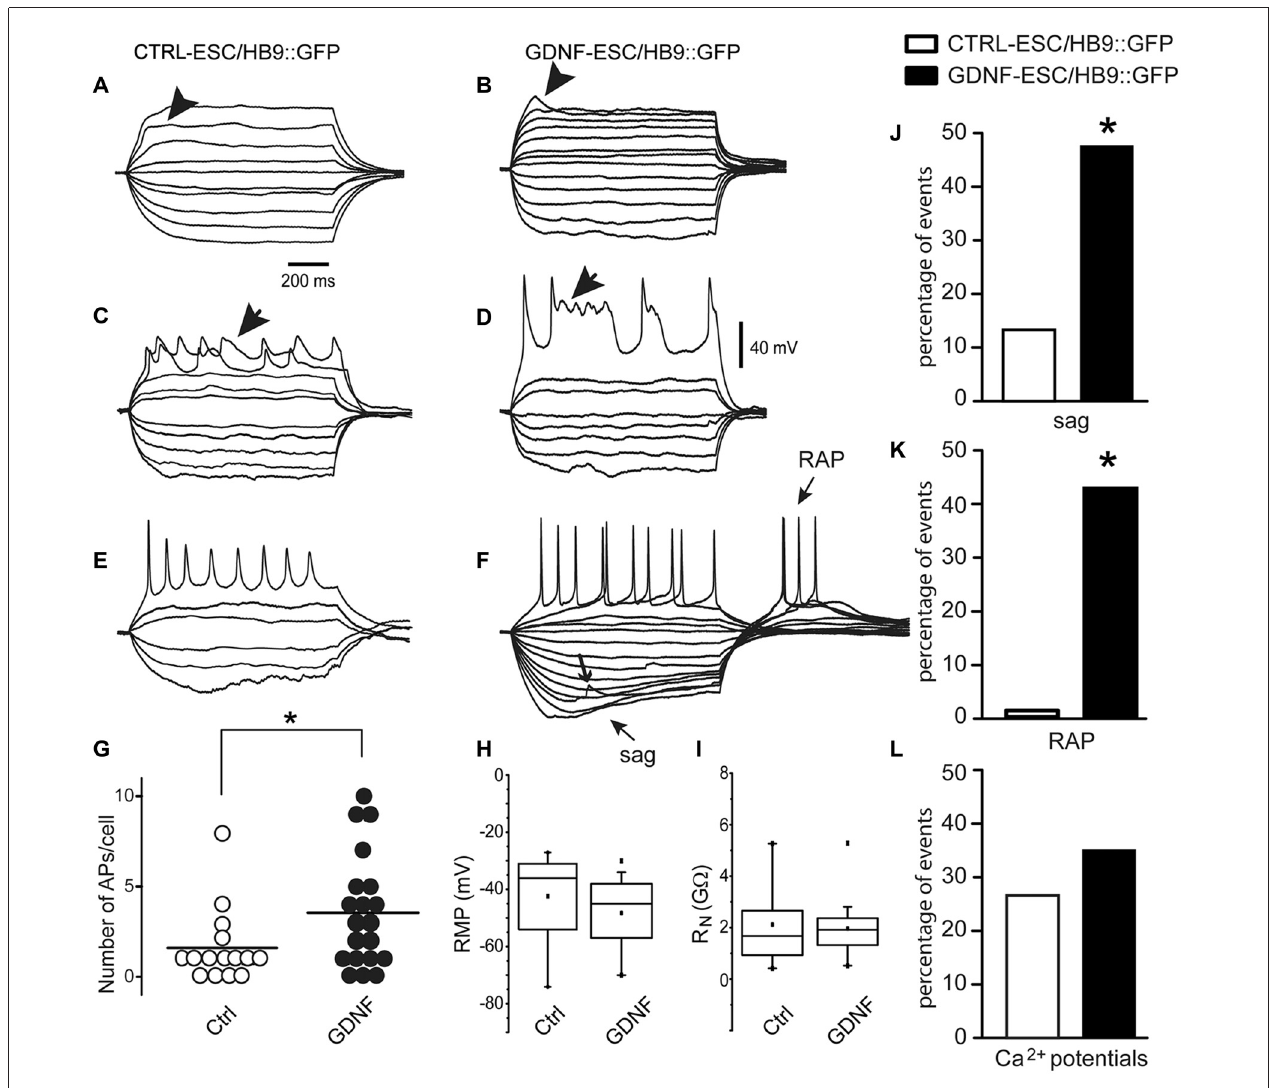
FIGURE 5 | Signs of excitability are more evident in MNs derived from GDNF-expressing cells. At 9 days in culture, CTRL-ESC/HB9::GFP (left column) and GDNF-ESC/HB9::GFP (middle column) MNs showed various stages of differentiation. (A–F) show voltage responses to depolarizing and hyperpolarizing current steps (not shown) injected intracellularly. (A,B) Arrowheads denote local responses appearing upon mostly passive electrical properties in both classes of neurons. (C,D) Arrows point towards regenerative responses with mixed sodium and calcium components. (E,F) Repetitive firing of action potentials (APs) in both classes of neurons. GDNF MNs showed larger inward rectification denoted by depolarizing sags upon hyperpolarization and rebound APs (RAPs) upon returning from it. Arrow denotes a putative spontaneous synaptic event (F) . (G) The average number of APs, significantly larger in GDNF-expressing cells. (H,I) Neither resting membrane potential (RMP) nor whole neuron input resistance (R N ) were significantly different. (J) Sag inward rectification was significantly larger in GDNF-expressing neurons. (K) RAPs after ending a hyperpolarization step were significantly higher in GDNF expressing neurons. (L) Ca 2 + events was not significantly different between both samples (see C,D ). ∗ p <